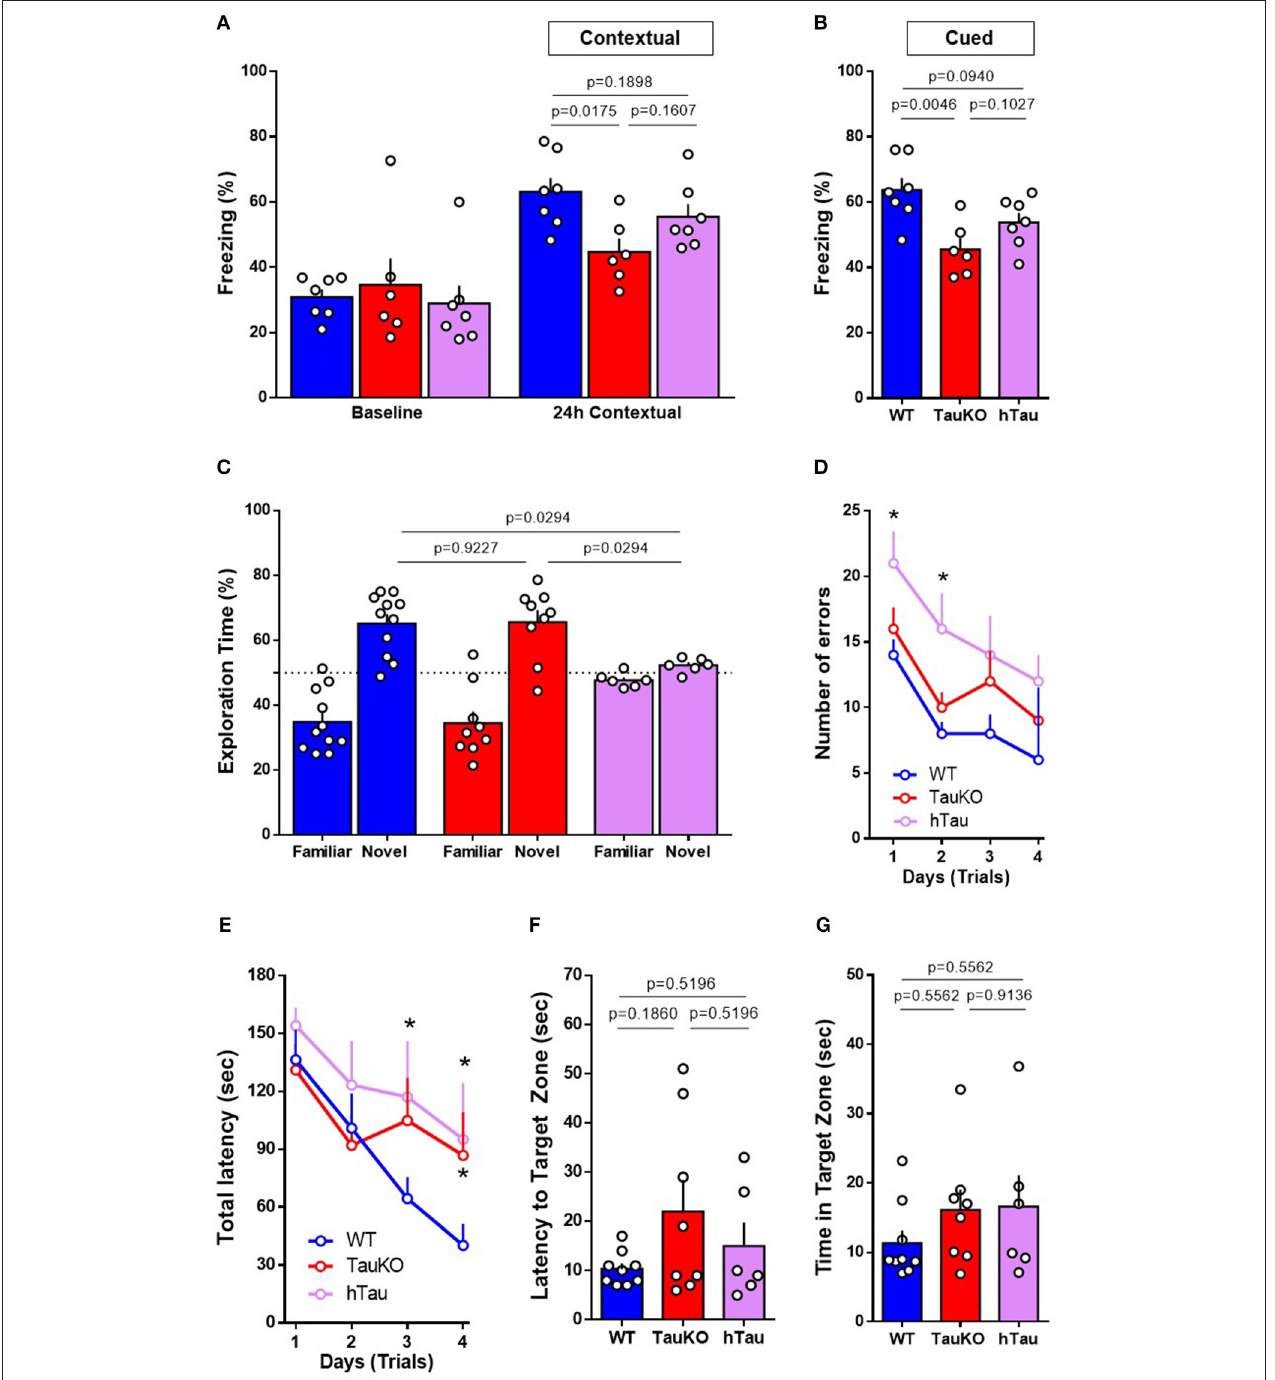
FIGURE 3 | Performance in the Fear Conditioning, Novel Object Recognition and Barnes Maze behavior tests. (A,B) Fear conditioning test performed with 15–19 weeks old WT, TauKO, and hTau mice ( n = 7 WT; 6 TauKO; 7 hTau). Percentage of freezing behavior during the (A) contextual and (B) cued FC. (C) Novel object recognition test performed with 15–19 weeks old WT, TauKO, and hTau mice ( n = 11 WT; 9 TauKO; 6 hTau). Exploration time of familiar and novel objects during the test phase. Time expressed in percentage. (D–G) Barnes maze test performed with 15–19 weeks old WT, TauKO, and hTau mice ( n = 9 WT; 8 TauKO; 6 hTau). (D) Total number of errors and (E) Total latency to find the target zone in 4 different trials/day, for 4 days during the acquisition/training phase of the Barnes maze test. (F) Latency to find and (G) time in the target zone 24h after the last training trial as a measure of spatial reference memory. Data are representative of at least two independent experiments. * p <